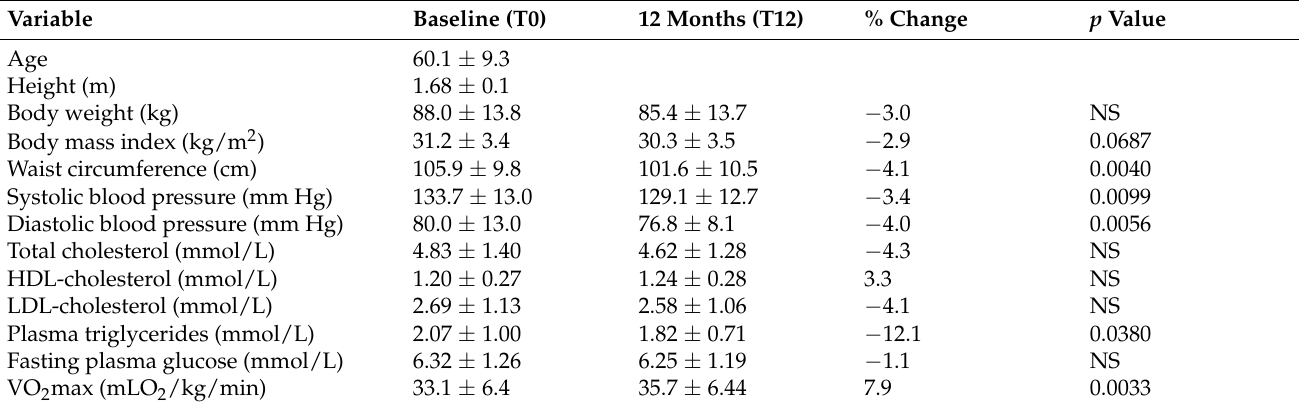
Table 1. Anthropometric and metabolic characteristics of participants ( n = 101).